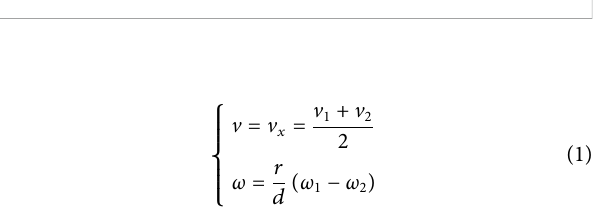
FIGURE 5 Differential-driveAMR ’ sarchitecture fl owchart. x e , y e ,and θ e arerespectivelytheestimatedpositionandorientationoftherobot; v ref and ω ref are the linear and angular reference speeds; ω 1ref and ω 2ref are the reference speeds for the right and left wheels; u 1 and u 2 are voltages applied to the motors; ω 1 e and ω 2 e are the angular estimated speeds; v e and ω e are the linear and angular estimated speeds.